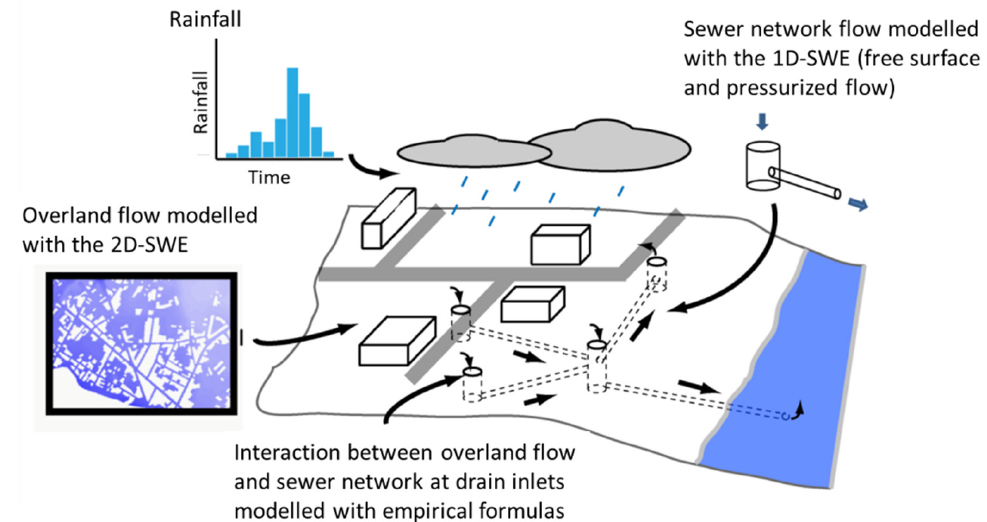
Figure 3. Schematic representation of the typical implementation of a 1D–2D dual ‐ drainage model.